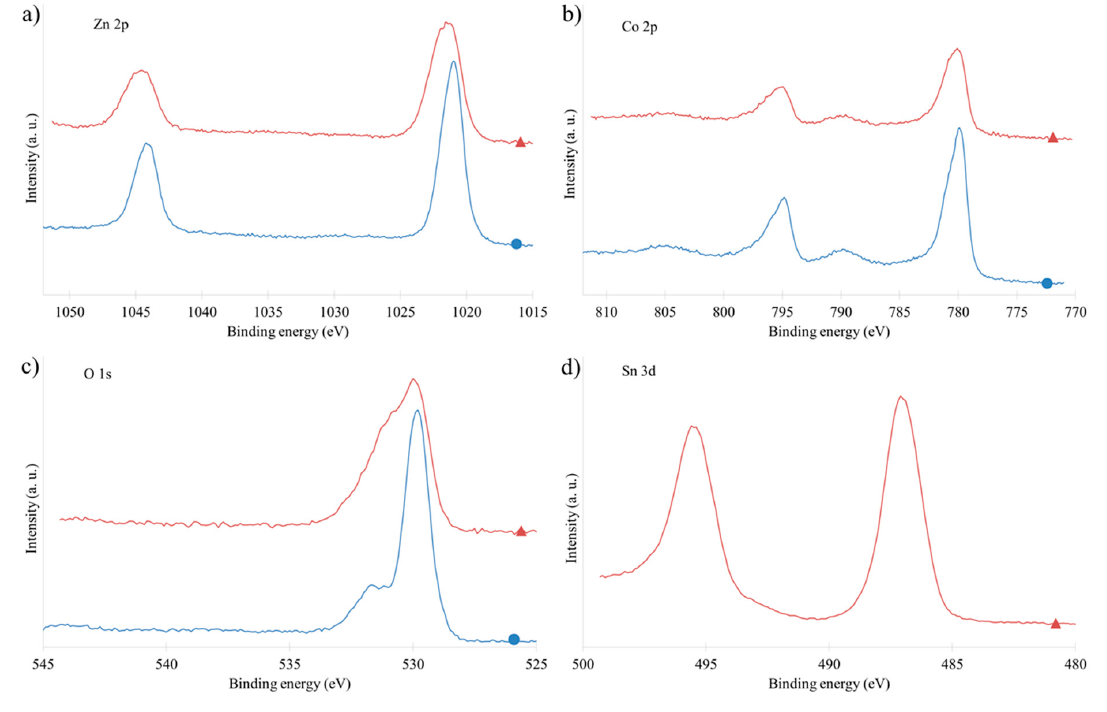
Figure 6. X-ray photoelectron spectroscopy (XPS) spectra of ( ● ) pure ZnCo 2 O 4 and ( ▲ ) ZnCo 2 O 4 /SnO 2 -20%: ( a ) Zn 2p region, ( b ) Co 2p region, ( c ) O 1s region and ( d ) Sn 3d region.